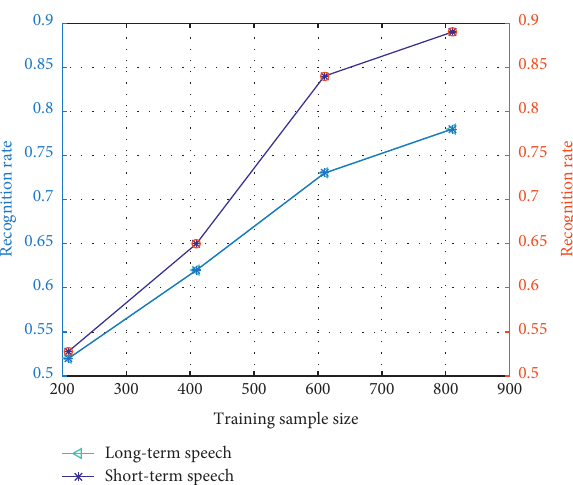
Long-term speech Short-term Figure 4: Recognition rate of 210 groups of strange voices under different training